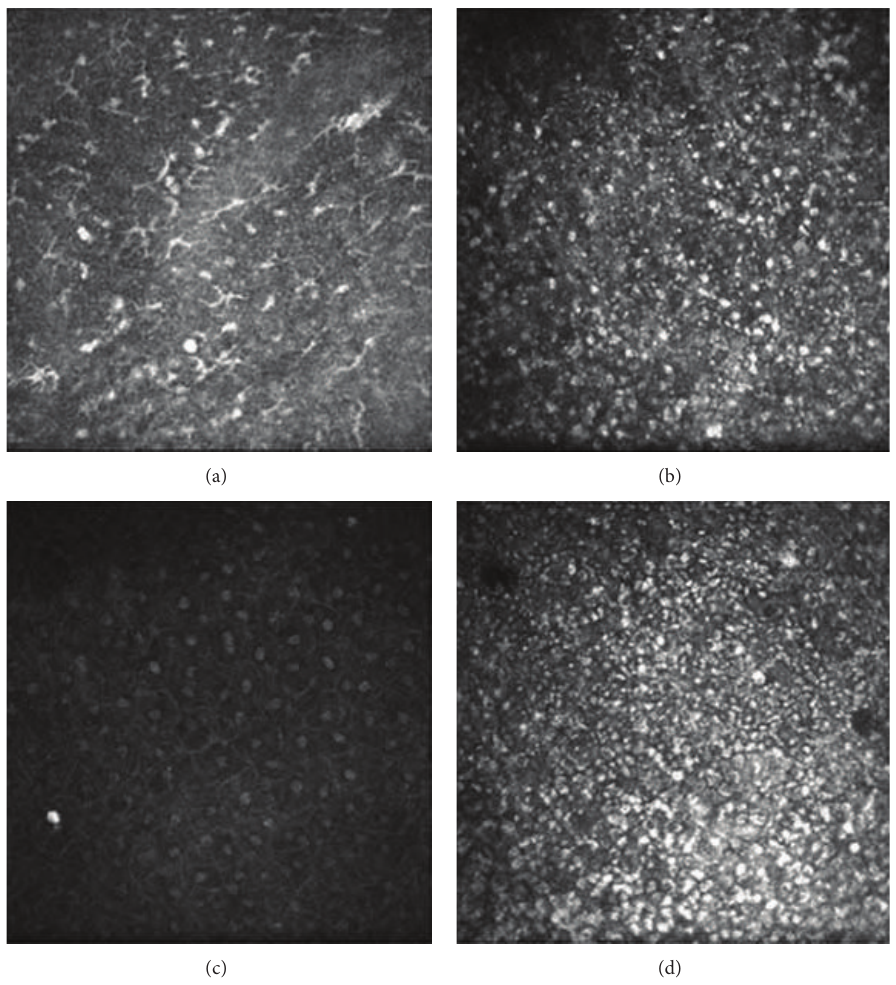
Figure 2: (a) The basal membrane surrounding the necrotizing regions displays abundant Langerhans cells aggregation. (b) Three months after the operation, confocal microscopy indicated that the number of immunocytes had clearly decreased. (c) Normal superficial corneal epithelium cells can be seen in the negative control cornea. (d) 12 months after conjunctival flap transplantation, the conjunctival epithelium cells are replaced by ancipital corneal cells with an epithelial-like appearance, with neovascularization and the proliferation of fibrous connective tissue.